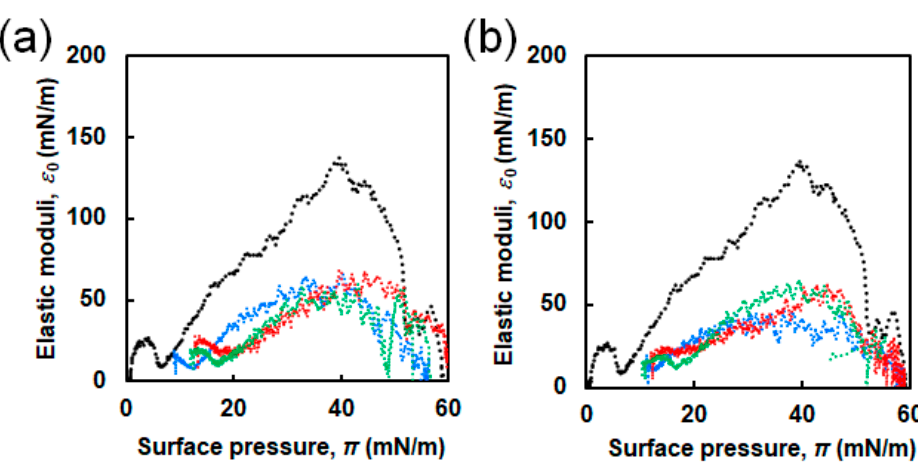
Figure 5. Elastic modulus ( ε 0 ) as function of surface pressure ( π ) for DPPC in the presence of EG n NFs at different concentrations: ( a ) 1.0 μ M and ( b ) 2.5 μ M; n = 6 (blue line), 12 (red line), 24 (green line). Black lines represent ε 0 – π plots for sole DPPC.